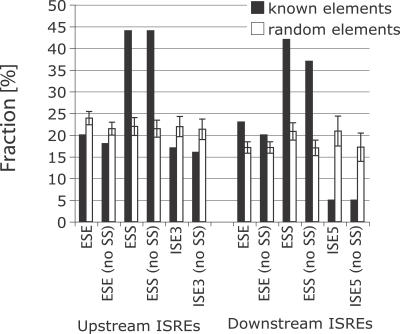
Overlap of ISREs with Known Classes of SREs, Namely ESE, ESS, ISE5, and ISE3 HexamersTwo sequences are defined as overlapping if one is a subsequence of the other. The fraction of ISREs that overlap with a class of hexamers is indicated in filled black bars. The white bars represent the mean fraction of 1,000 comparisons of ISREs with sets of random hexamers of equal size as the class (error bars depict one standard deviation). Refer to Protocol S1 on details of the compilation of known splicing regulatory sequences from multiple sources. “No SS” refers to using ISREs without splice-site like sequences.